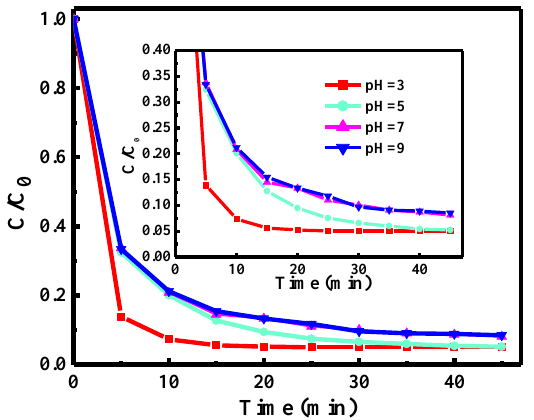
Figure 4. The different pH value of RhB degradation (2 nd Fe-g-C 3 N 4 only). The solution pH was adjusted by 0.1 mol/L HCl or NaOH, and the pH change of the treated solution was small during the reactions (±0.2).